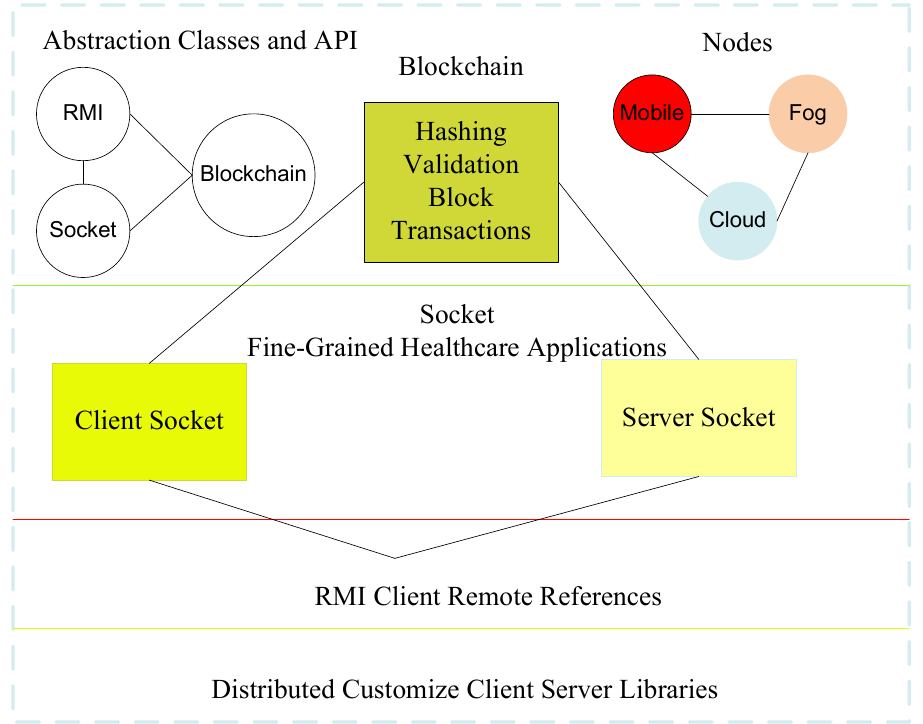
Figure 2. Abstraction of Socket RMI Blockchain for Healthcare